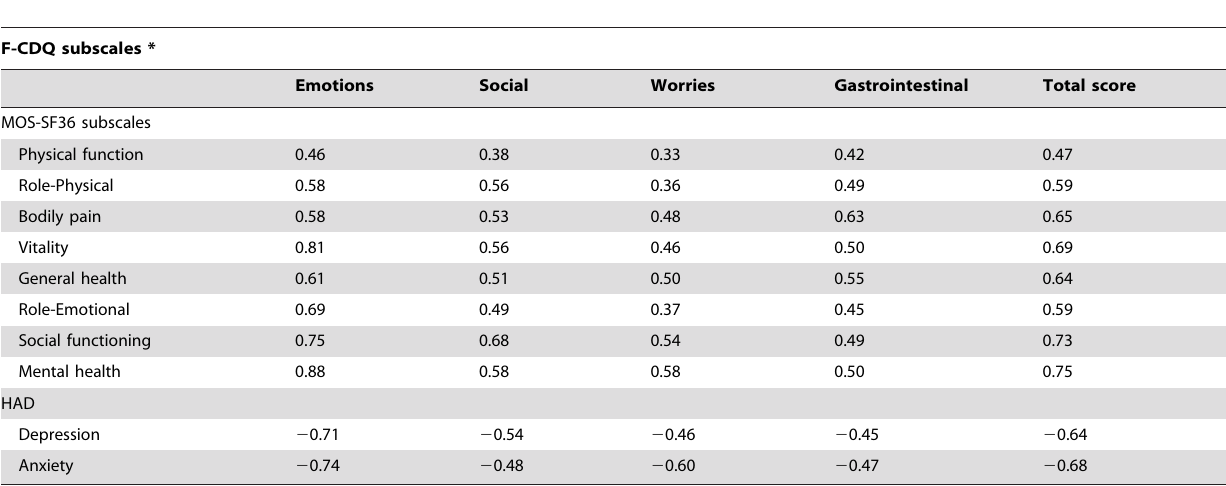
Table 4. Associations between the French version of the ‘‘Celiac Disease Questionnaire’’ (F-CDQ) and the MOS-36 and the HAD